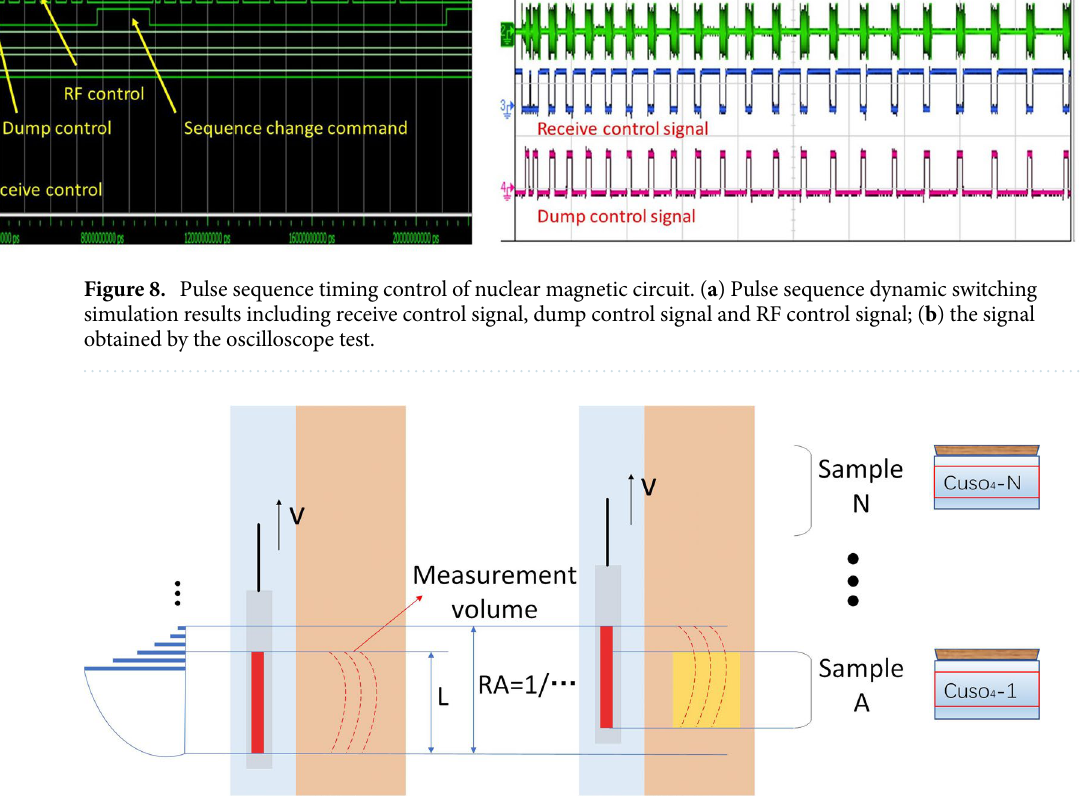
Figure 9. Diagram of an instrument in motion. The logging tool is moving at a speed of v, and the red rectangle represents the RF coil with a length of L . The length is about 60 cm. If the tool does not move during the measurement cycle (i.e., a stationary reading is obtained), the vertical resolution (VR) equals the length of the antenna ( L